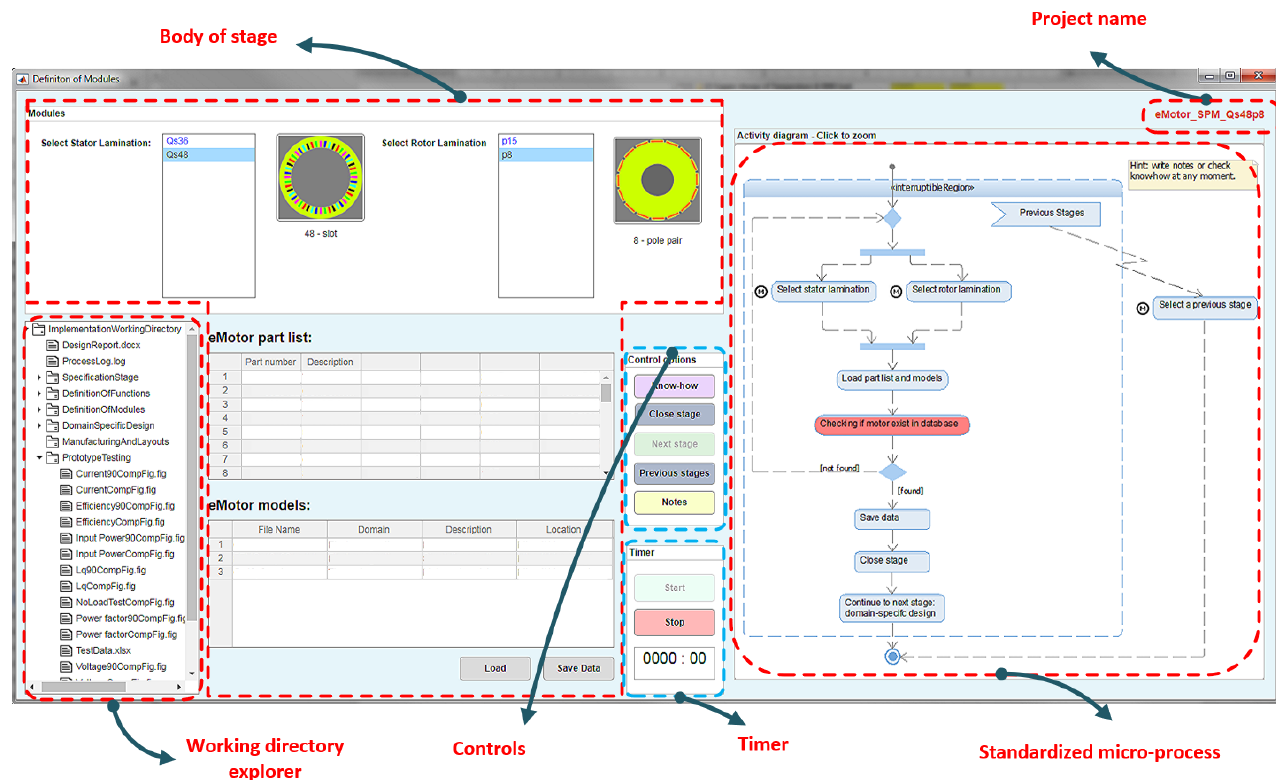
Figure 11. Structure of the user interfaces for each module.